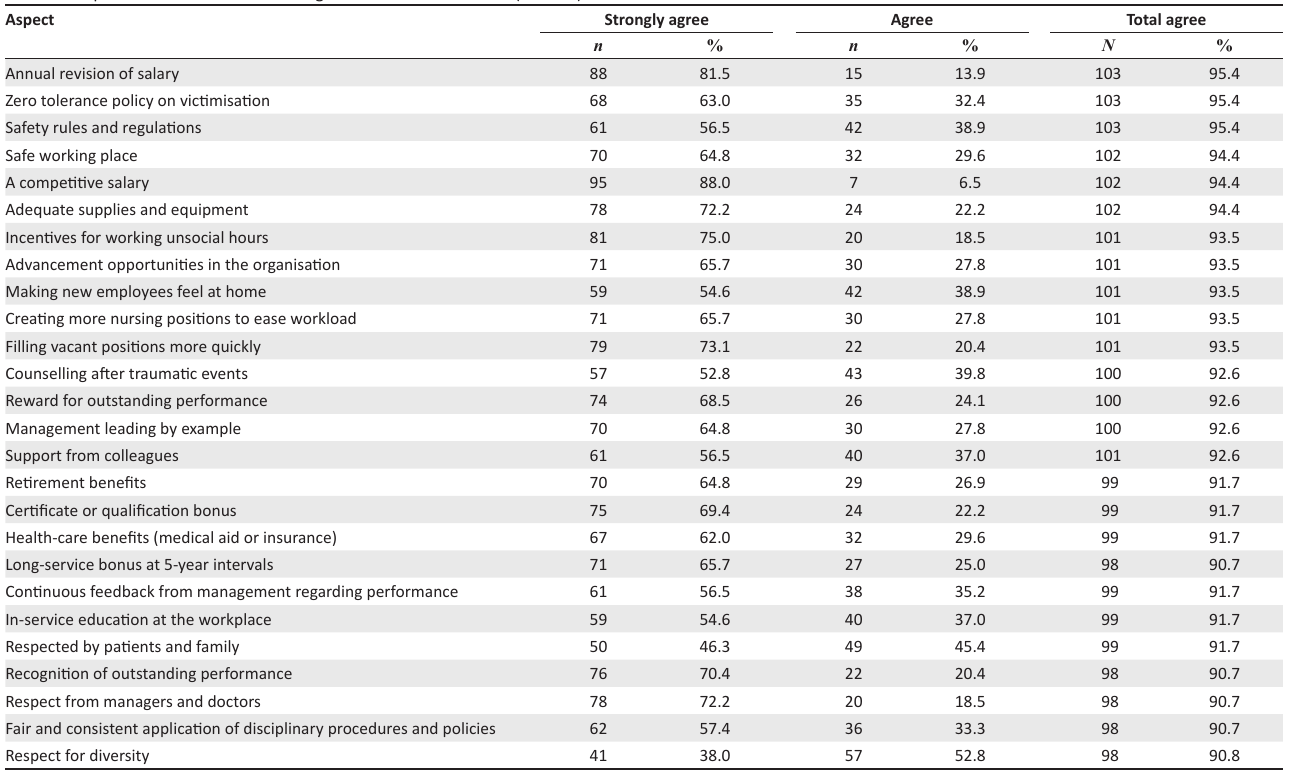
TABLE 2: Aspects that would influence registered nurses’ retention ( n = 108).